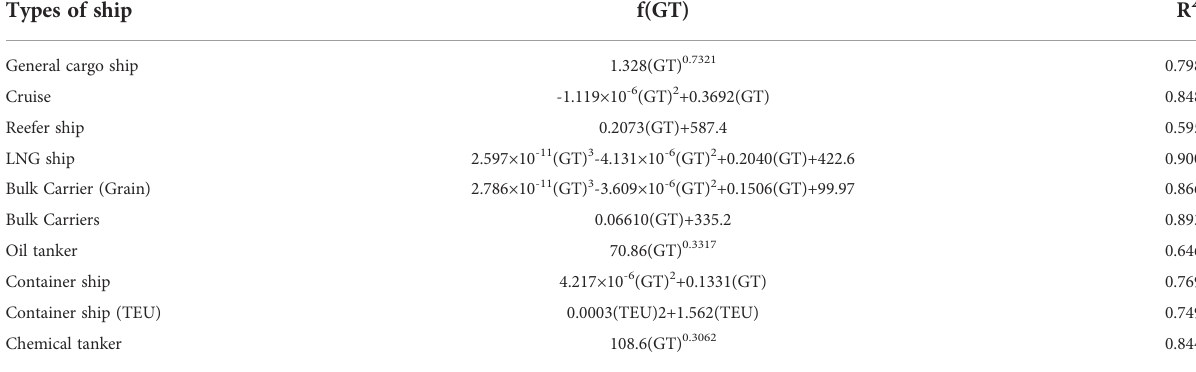
TABLE 2 Relation function of auxiliary engine-rated power and gross tonnage of various types of marine auxiliary